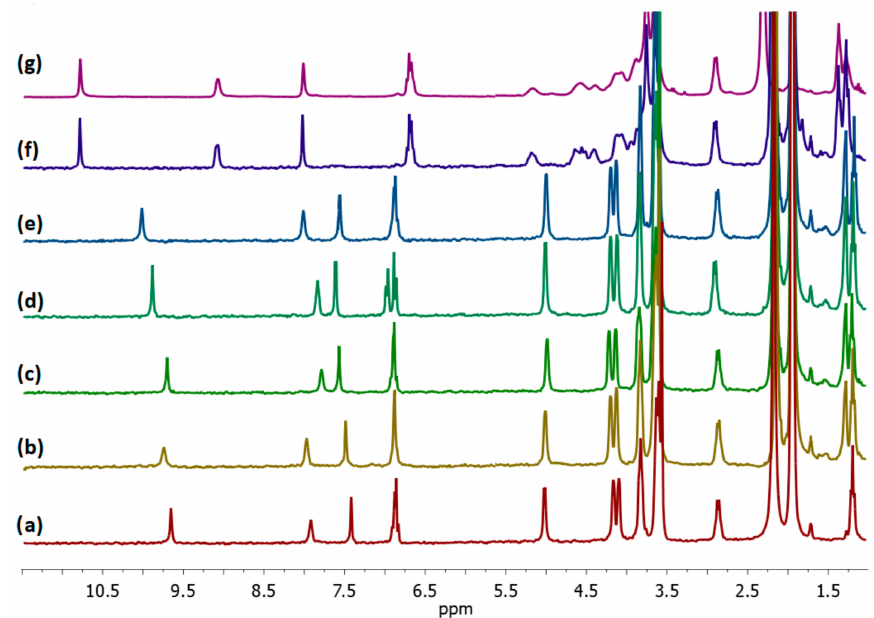
Figure 3. 1 H NMR spectra of receptor 1 recorded in CD 3 CN before ( a ) and after addition of solid salts: ( b ) K 2 SO 4 , ( c ) KN0 3 , ( d ) KBr, ( e ) KCl, ( f ) CH 3 COOK, ( g ) mixture of tested potassium